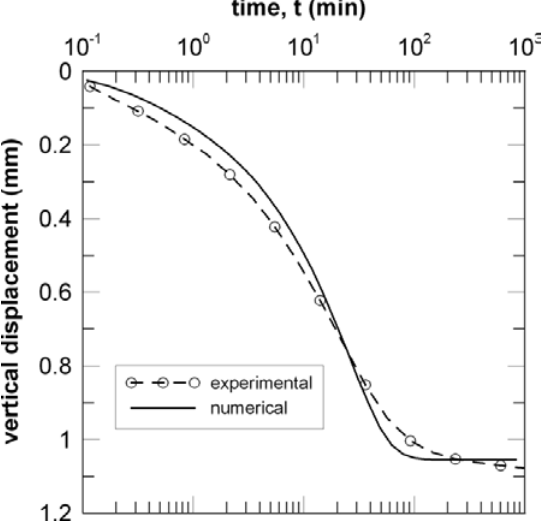
Fig. 3 – Measured and predicted consolidation curves for a single mechanical load increment at null electric